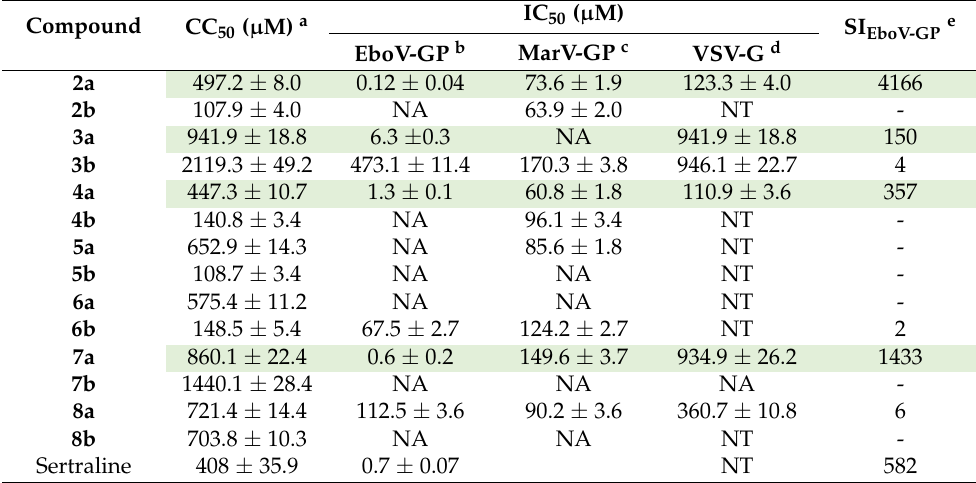
Table 2. Antiviral activity of the compounds 2–8 a–b against Ebola pseudotype viruses (rVSV- ∆ G- EboV-GP) and Marburg pseudotype viruses (rVSV- ∆ G-MarV-GP).